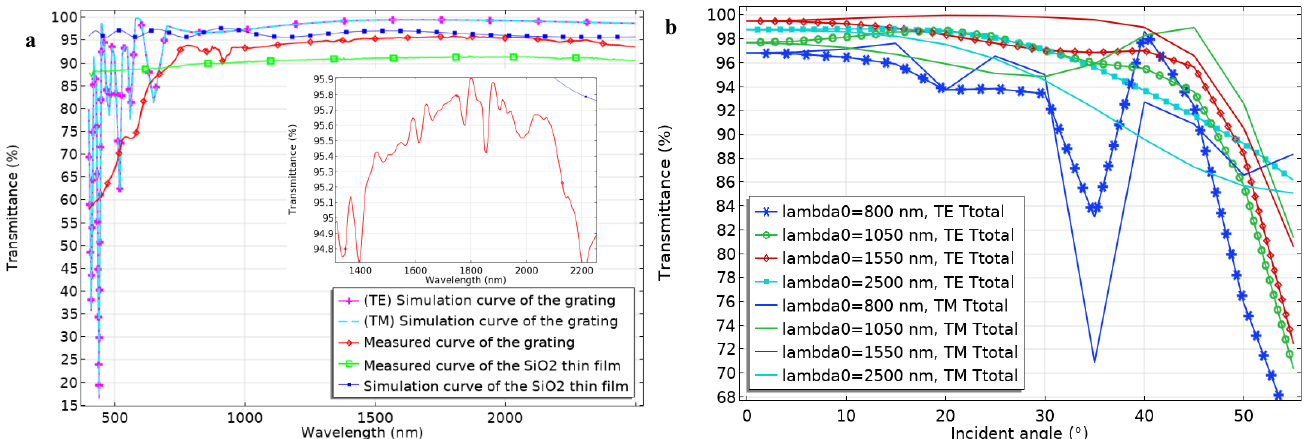
Figure 6. Transmittance of the samples. ( a ) Comparison of measured and simulated transmittance spectra of the samples as a function of wavelength at normal incidence. The inserted curve is the measured transmittance of the grating. ( b ) Simulated transmittance of the 2D grating as a function of incident angle.